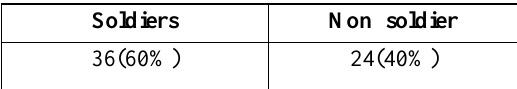
Table 3. The frequency of patients with cutaneous leishmaniasis according to occupation.